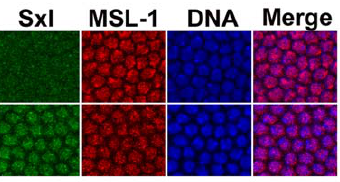
Figure 8. Sxl and the DCC are transiently co-expressed in female embryos. During mid cycle 14, Sxl (green) and the DCC (red - mostly from anti-MSL-1 antibody) can be simultaneously detected in females. MSL-1 overlaid on DNA (blue) signal (Merge). Top set of images from males, as determined by the lack of specific Sxl signal, lower set is of females. The ant-MSL-1 signal in the female nuclei is less intense and generally covers a larger area than in males, as might be expected for their double dose of X chromosomes. As previously noted [46], the signal in males is more frequently at the nuclear periphery.